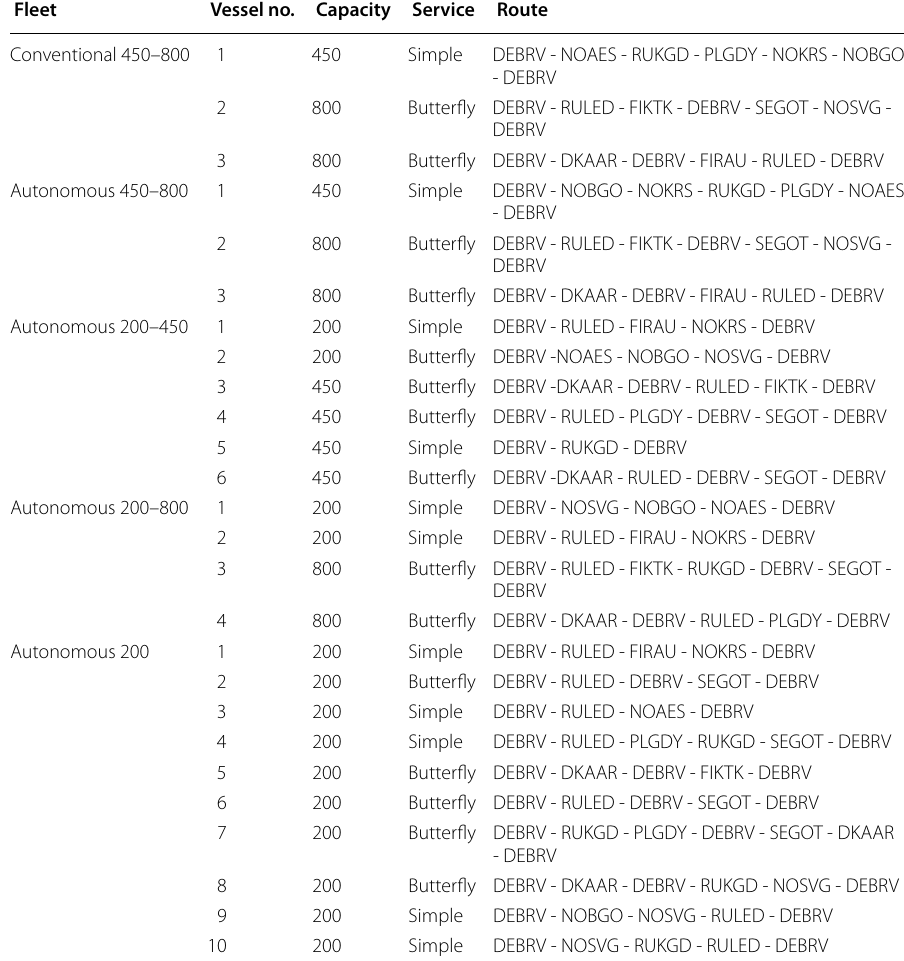
Table 4 Vessels, service types and routes in the solution obtained for the different fleets Fleet